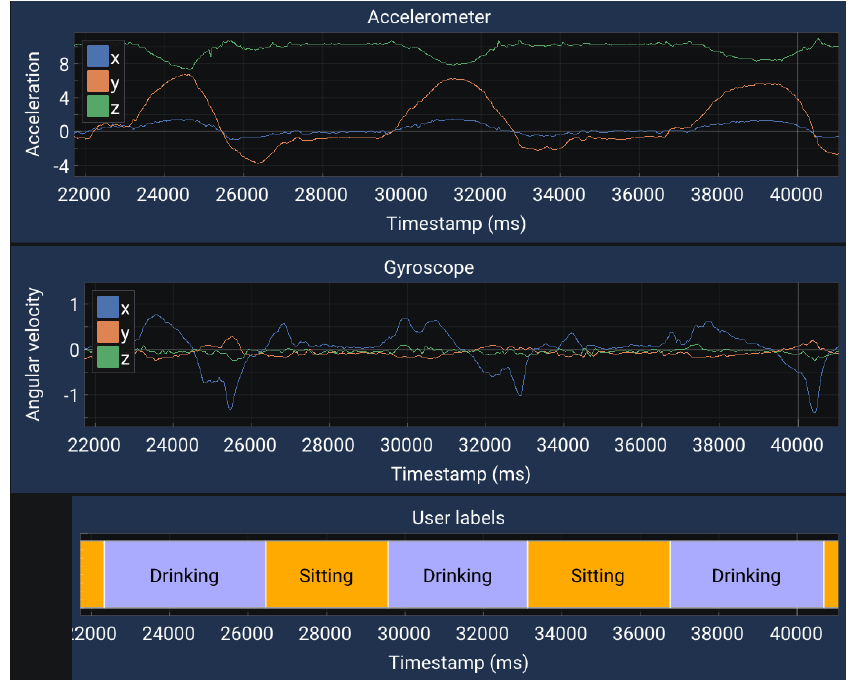
Figure A7. 20 s extracted from DRINKING session of subject